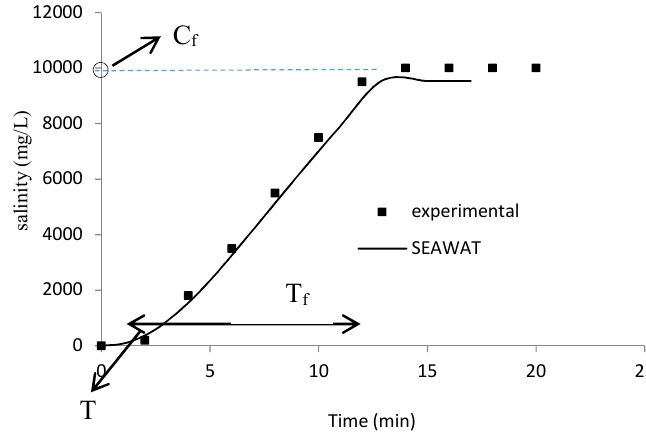
Fig. 3: Breakthrough curve obtained from H2C2Q2 experiment